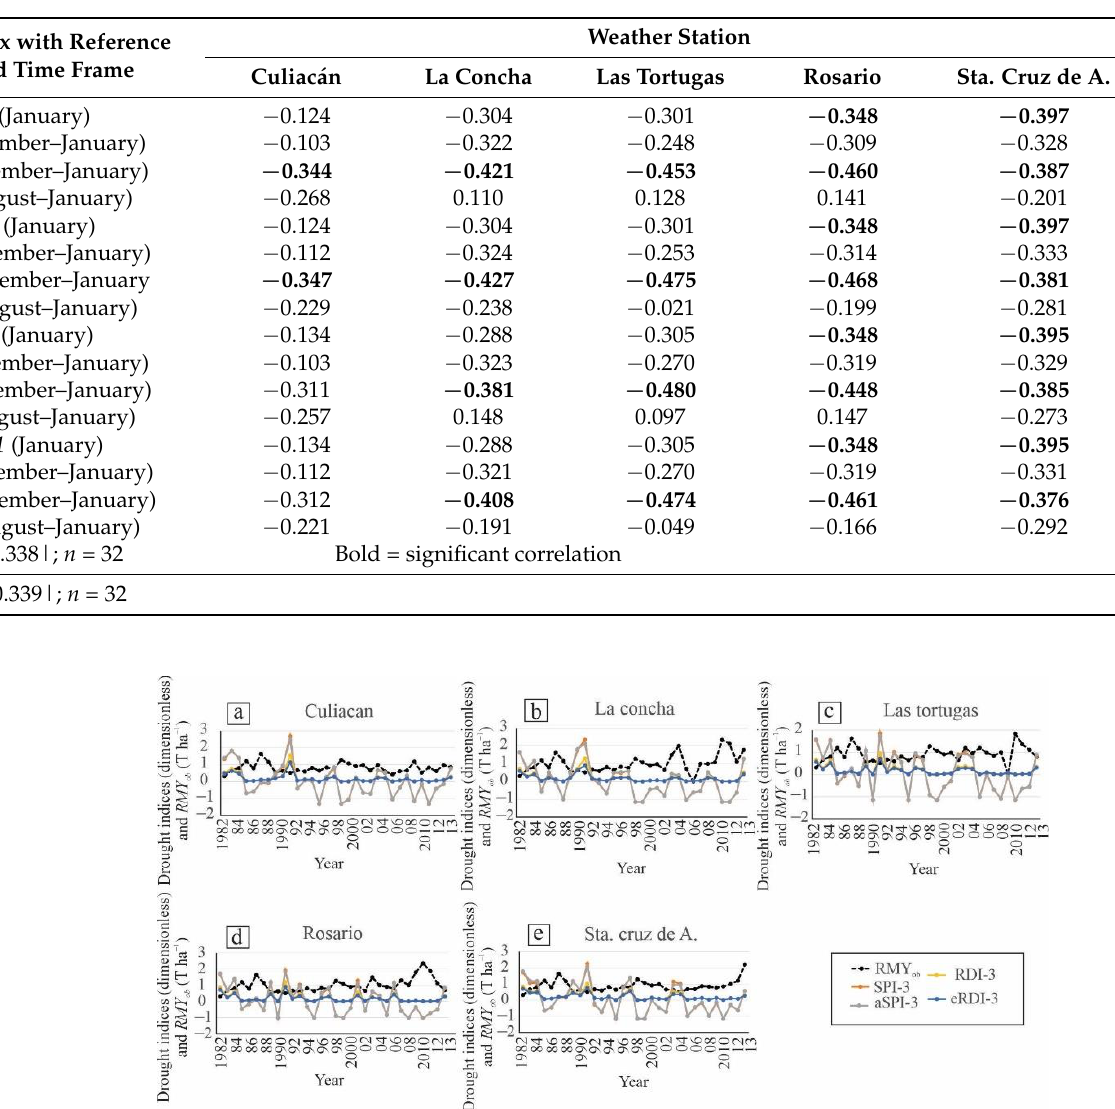
recorded at the Culiacán station ( aSPI-3 = −1.42 and SPI-3 = −1.40; Figure 3a) for 1998. The minimum value of yield was recorded for Las Tortugas in 2009 ( RMY ob = −2.46; Figure 3c).